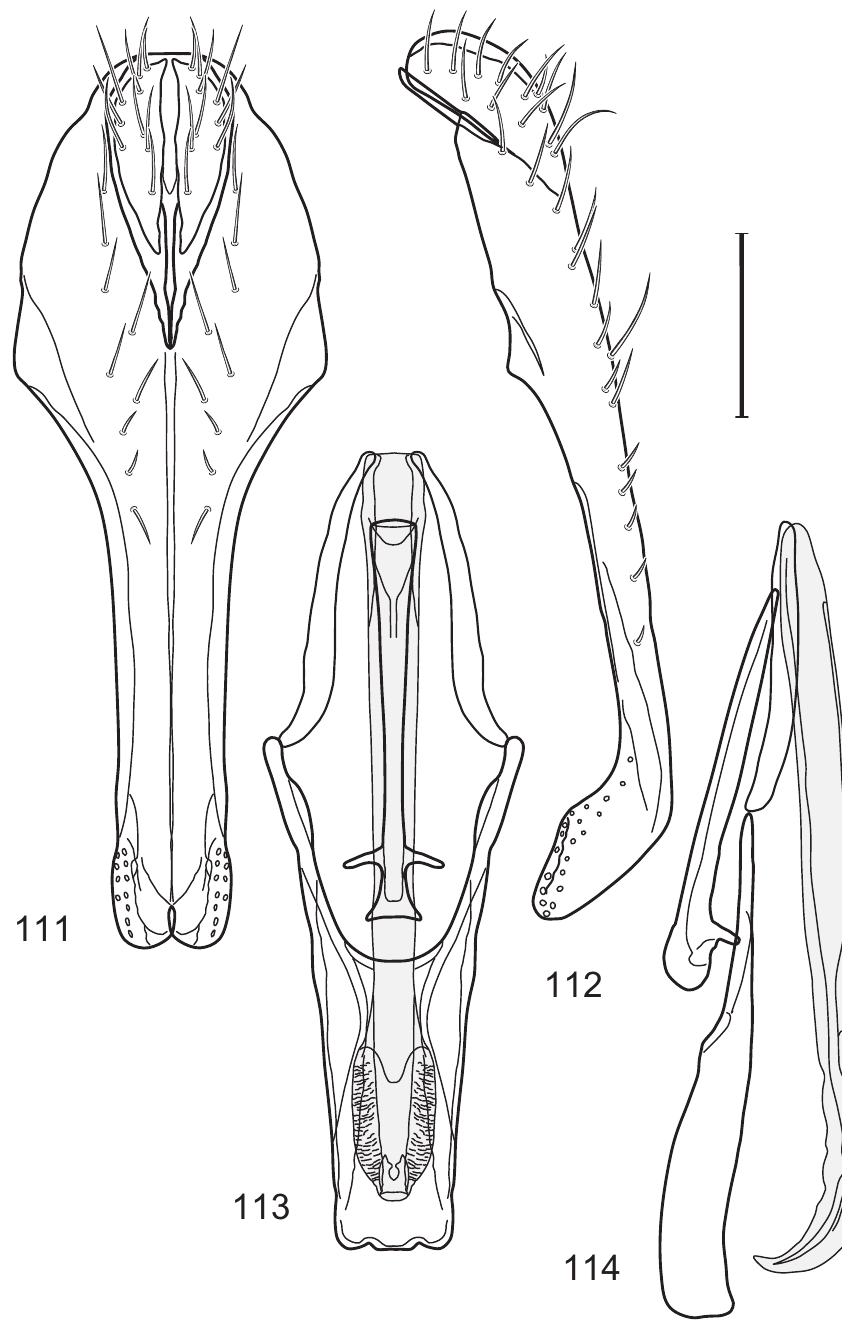
Figures 111–114. Hydrochasma parallelum sp. n. (Trinidad: St. Andrew: Low Manzanilla) 111 epan- drium and cerci, posterior view 112 same, lateral view 113 internal structures of male terminalia (aedeagus [shaded], phallapodeme, gonite, hypandrium), ventral view 114 same, lateral view. Scale bar = 0.1